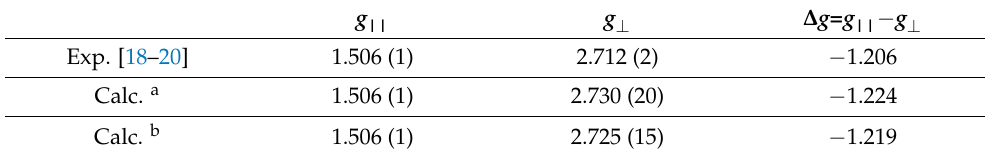
Table 2. The EPR g factors for the axial Ce 3+ center in BaWO 4 single crystal.